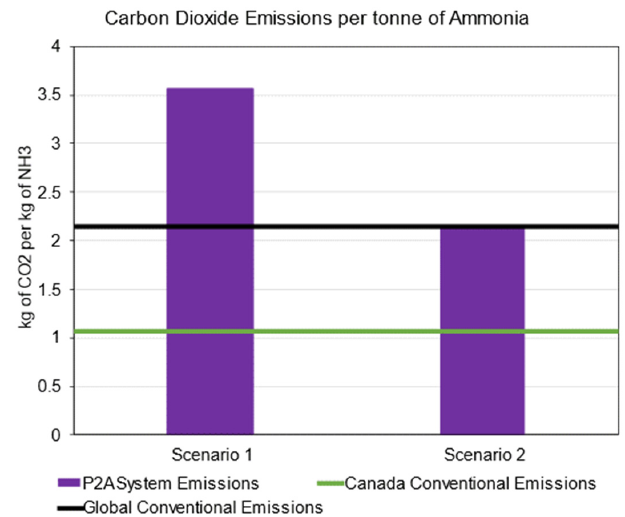
Figure 7. Greenhouse gas emissions from the P2A system’s two